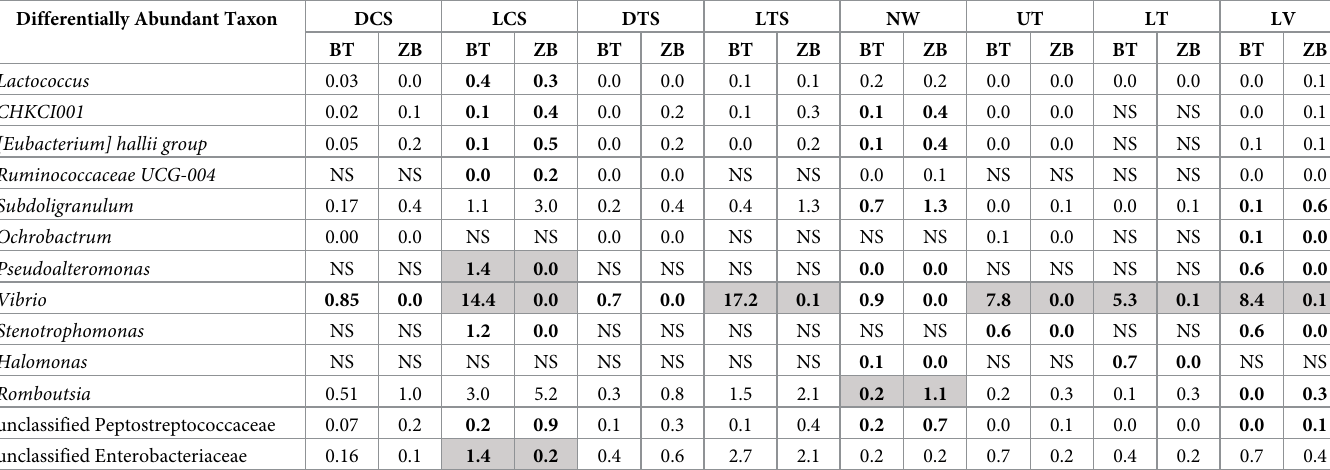
Table 4. Differentially abundant shared